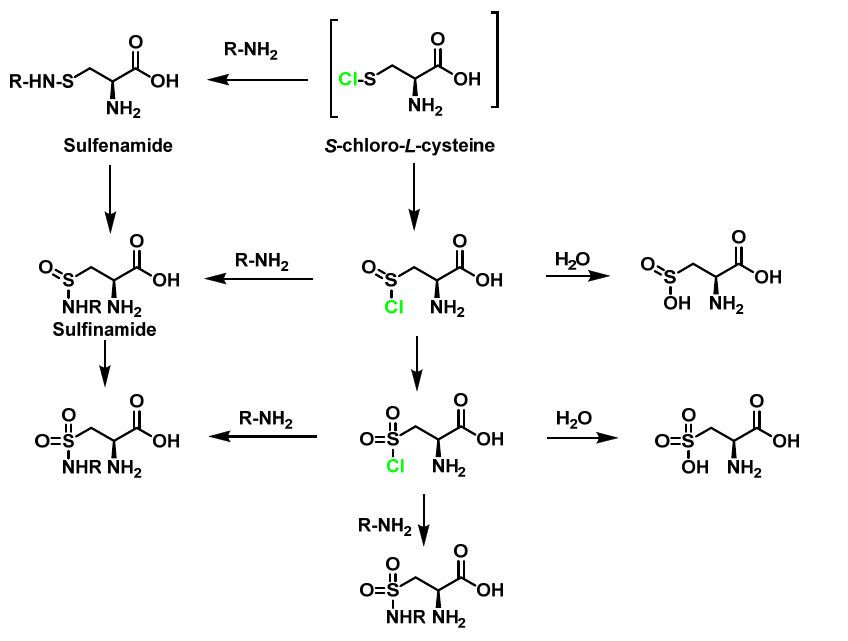
Figure 31. Proposed reaction pathways for S– N cross-linking and oxidation by HOCl of Cys. The oxidation of the Met side chain by HOCl is less complex, where methionine sulfoxide is the only product observed with even a 2.5-fold molar excess of HOCl over N -acetyl-Met [85]. Methionine sulfoxide is a stable oxidation product of Met, and it is likely that this oxidation plays a critical role in the bactericidal action of HOCl. The reaction of methionine with HOCl initially produces a sulphonium chloride, which is subsequently hydrolysed to give sulfoxide as the final product. Assuming that the same product is formed with chloramines, then a mechanism can be proposed in which hydrogen ions promote the transfer of Cl + to sulphur [86], as shown in Figure 32.